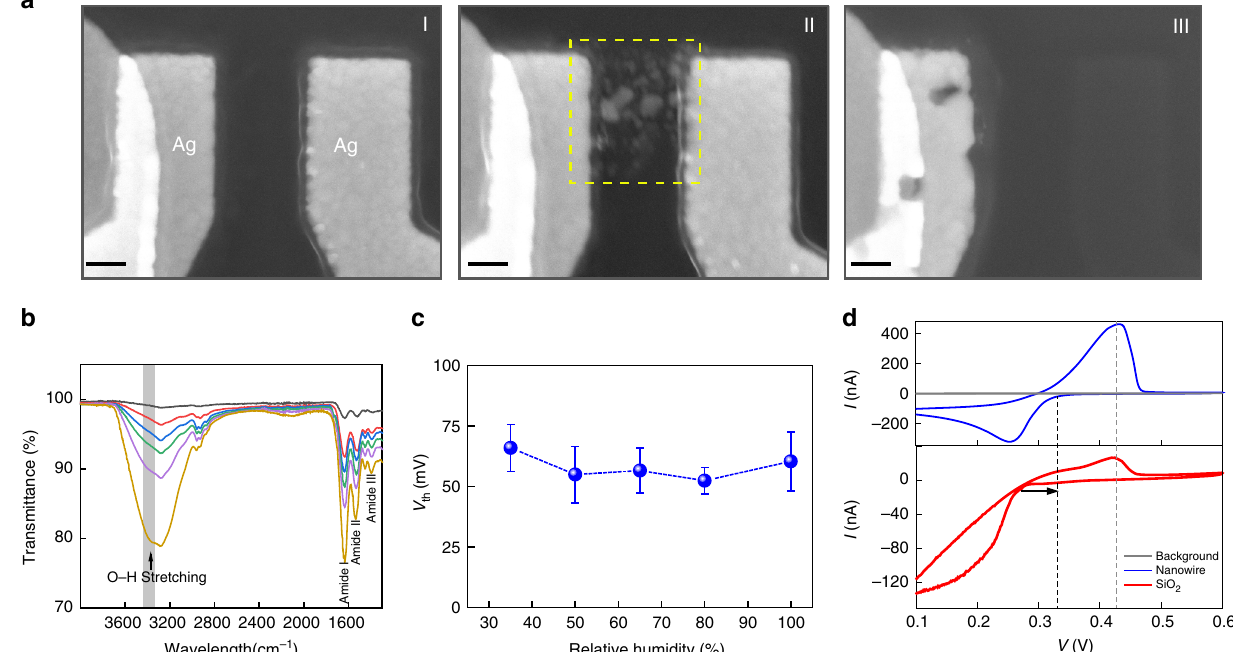
Fig. 3 Conducting fi lament and switching dynamics. a SEM images of a protein-nanowire device (I) before, (II) after electroforming, and (III) after removal of the protein nanowires with ultrasonication. Scale bars, 100 nm. b FTIR spectra of a protein-nanowire fi lm (~200 nm thick) at relative humidity (RH) of 0% (gray), 35% (red), 50% (blue), 65% (green), 80% (purple) and 100% (yellow). The broad peaks ~3400 cm − 1 correspond to O-H stretching band in free water 42 . The increased intensity indicates increased water adsorption in the fi lm at higher RH. The increased intensities in other amide peaks could be caused by protein segments that became more mobile after moisture fi lling interstitial voids. c Average turn-on voltage ( V th ) from devices ( N = 12) in different RH. The error bars represent the standard deviation (s.d.). d Cyclic voltammetry curves using protein-nanowire coated Au cathode (blue) and SiO 2 -coated Au cathode (red) in Ag + (5 mM) solution at a rate of 25 mV·s − 1 . The background curve (gray) was performed without Ag + . The onset reduction potential shows a right shift (black arrow) from ~0.25 V to ~0.35 V when switching from SiO 2 coating to protein-nanowire coating in the Au cathode, whereas the oxidation peak (~0.43 V) does not